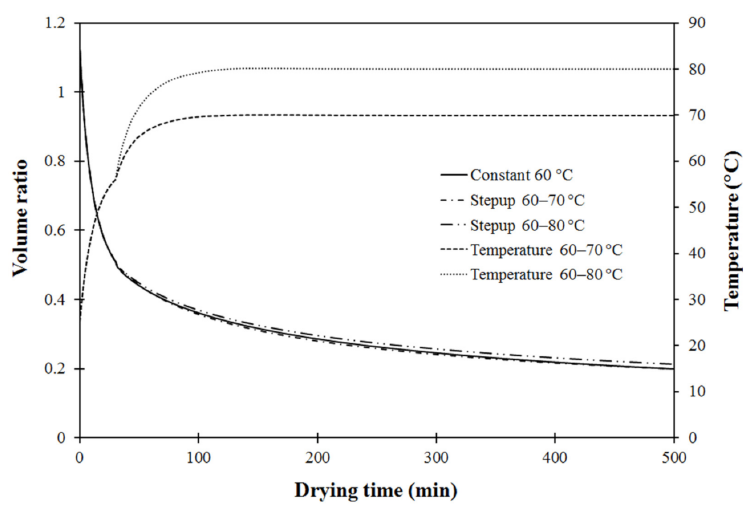
Figure 7. Comparison of simulated shrinkage ratio of carrot cubes at fixed 60 ◦ C and two modes of step-up